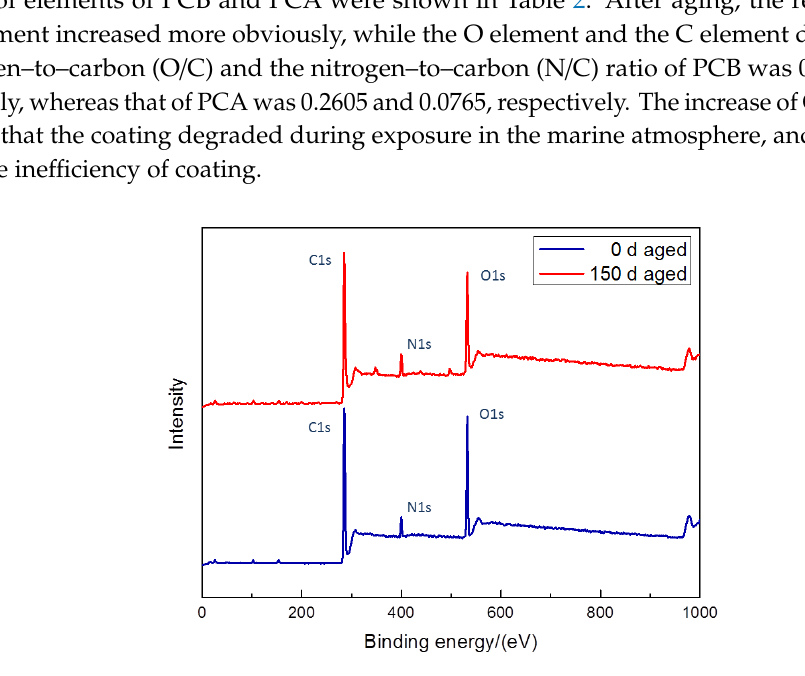
Figure 12. XPS full spectrum analysis before and after polyurea aging. Table 2. Elemental composition and atomic ratios of polyurea before and after aging.